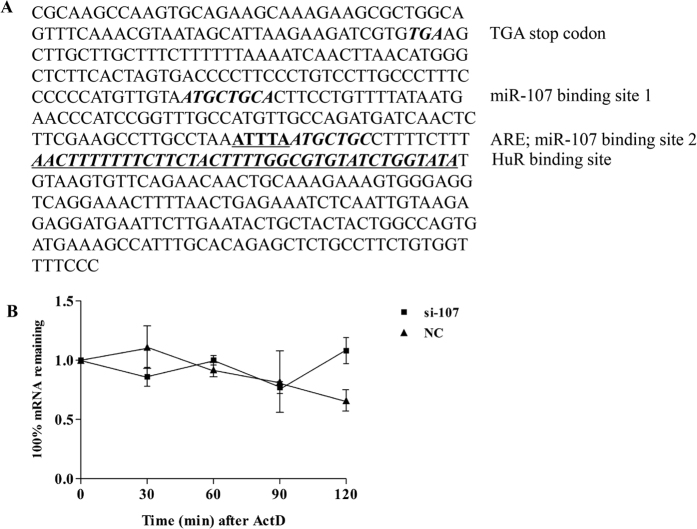
miR-107 negatively regulates NF1 expression by degrading its mRNA stability.(A) The predicted ARE element and HuR binding site within the NF1 3′-UTR. (B) mRNA stability of NF1 in MGC803 cells treated with NC or si-107was measured by real-time PCR.